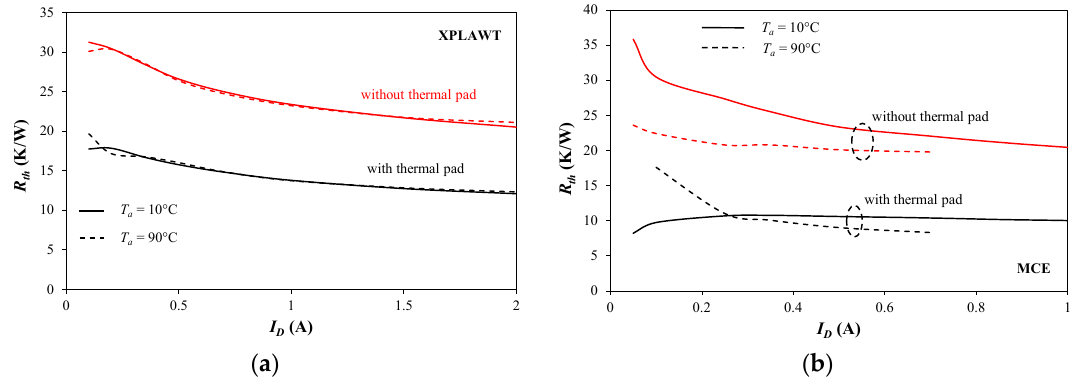
Figure 8. Measured dependences of thermal resistance on forward current for different cold plate temperature values for: ( a ) the XPLAWT; ( b ) MCE diode.